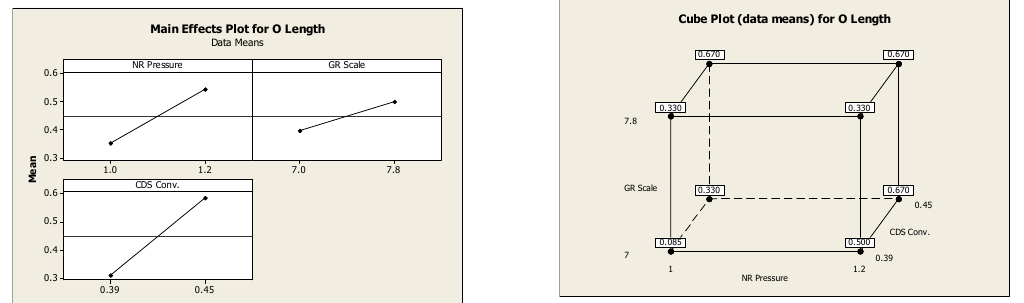
Fig. 3. Design of Experiment in the crimper